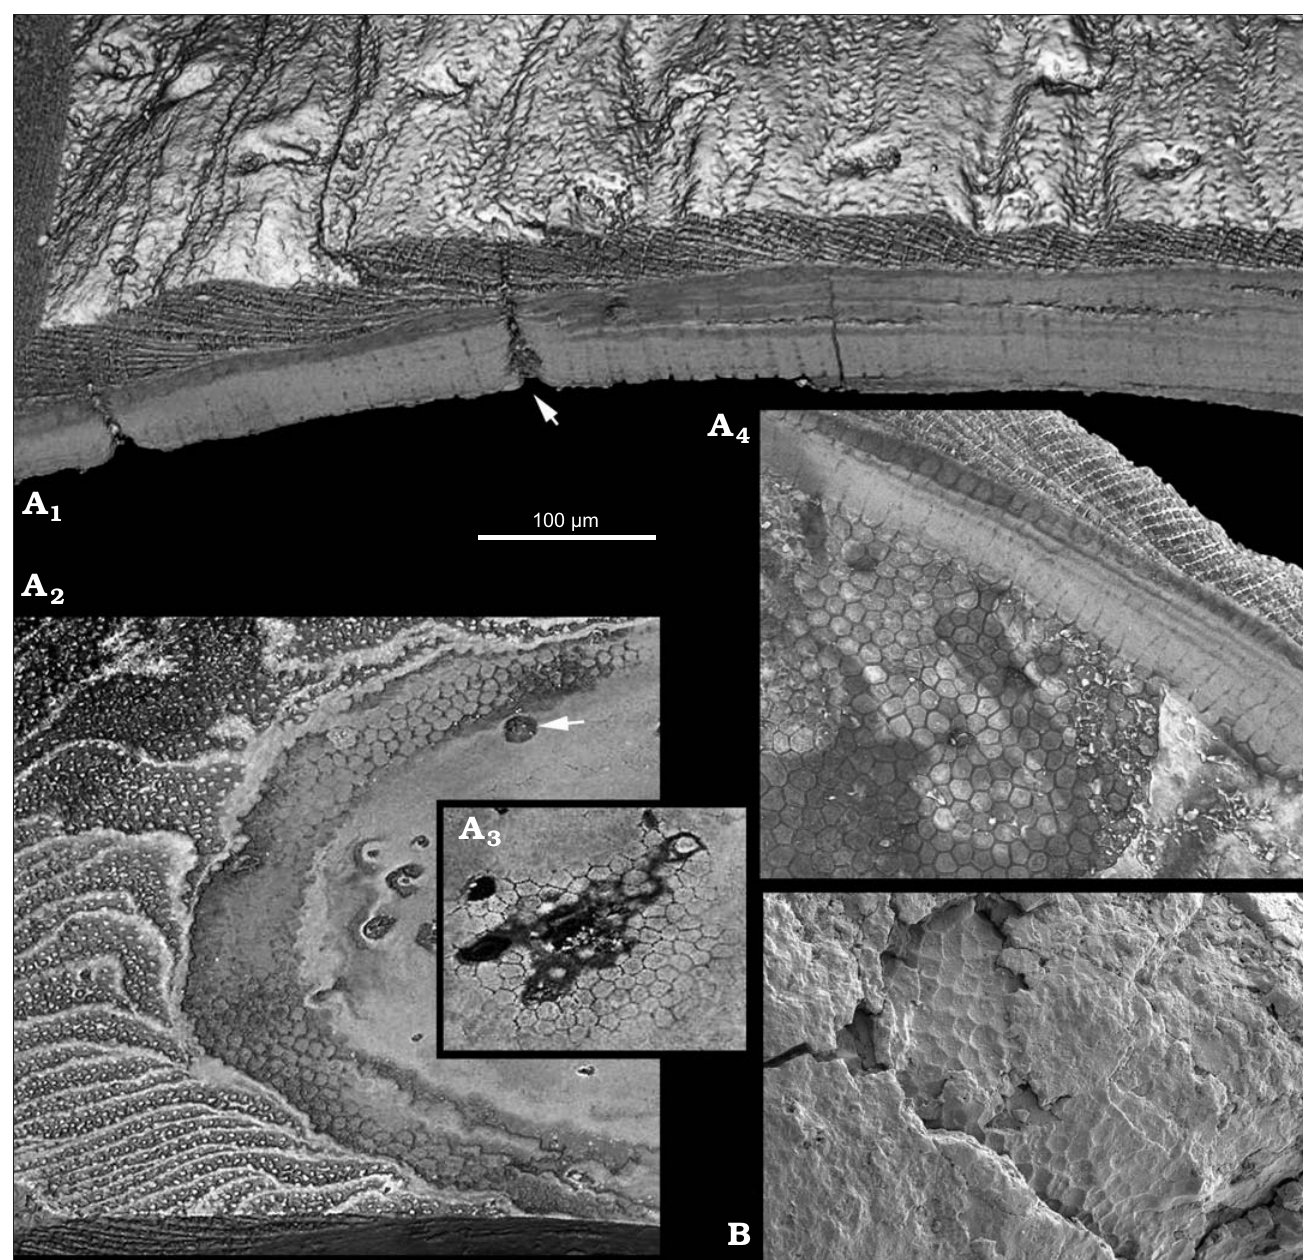
Fig. 1. Stem-group brachiopod Oymurania gravestocki Ushatinskaya in Kouchinsky et al., 2015 from the lower Cambrian Perekhod Formation, Achcha- , virtual section gyi-Kyyry-Taas section, Siberia. A . SMNH X5299, SRXTM volumetric renderings through the proximal part of medium-sized shell; A 1 through the shell in radial direction showing the inner compact layer consisting of perpendicularly oriented prismatic columns and the outer spacious layer , virtual tangential featuring the acrotretoid columnar microstructure; note perpendicular Micrina–Setatella type canals (arrowed) penetrating the shell; A 2 section through the lamellar acrotretoid microstructure (left in the image) and prismatic inner part (right in the image) of the shell; note cross-sections , fragment of a deeper virtual tangential section through the inner layer showing cross-sections of through the Micrina–Setatella type canals (arrowed); A 3 , polygonal ends of the prismatic columns on the inner shell surface. B . SMNH X5294, SEM image showing polygonal texture in broken the prisms; A 4 section near the outer surface of apical part of the shell (see Kouchinsky et al. 2015: fig. 12C 1